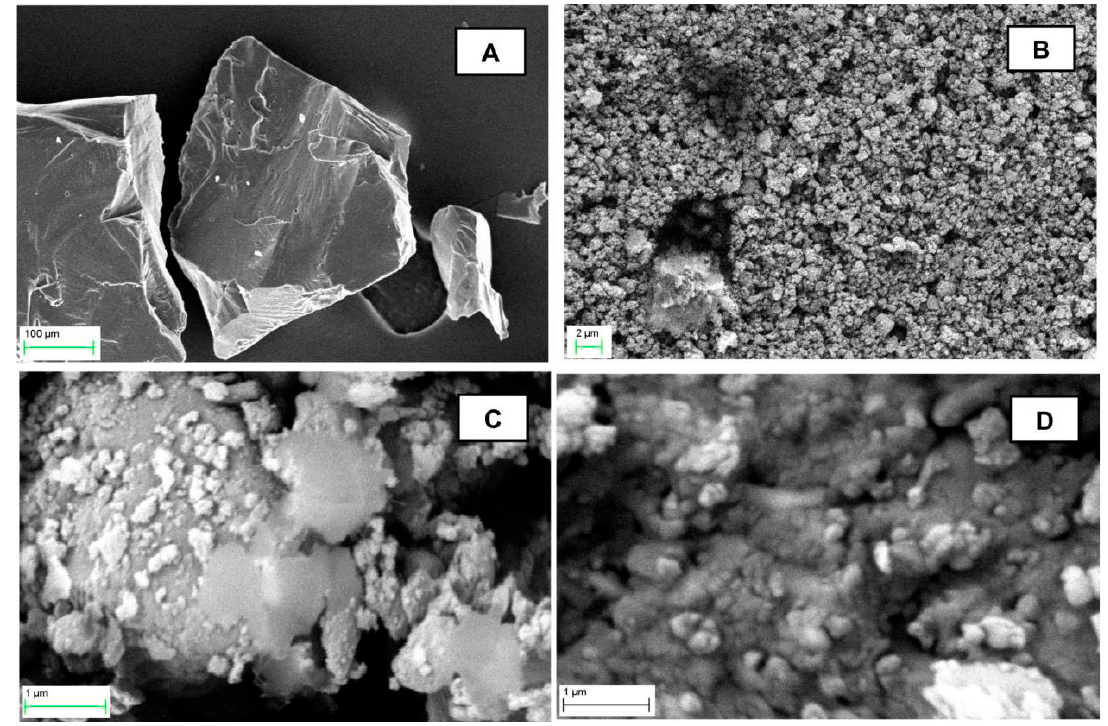
Figure 4. SEM images of the quartz samples: ( A ) undisturbed; ( B ) quartz groundat 13.6 kJ / mol; ( C )quartz ground at 16.3 kJ/mol; ( D )quartz ground at 32 kJ/mol.